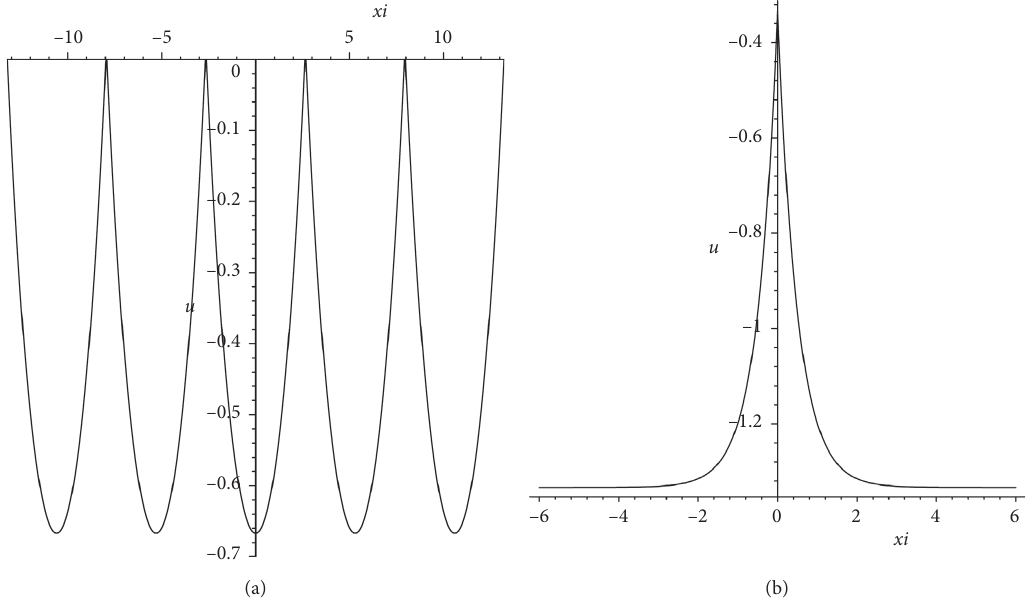
< g < g . (d) g � g . 2 1 1